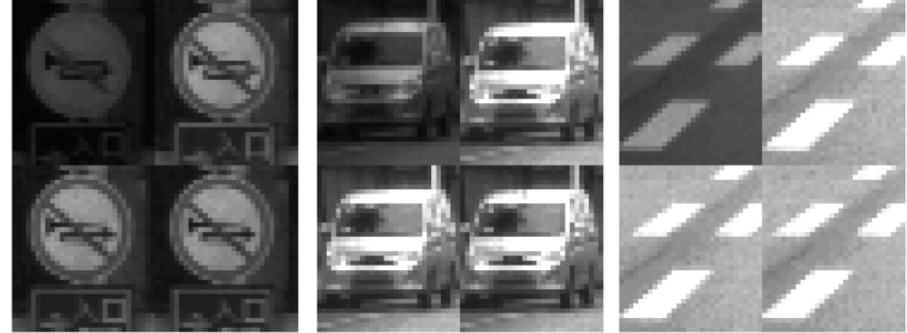
Figure 5. Three sample parts of source RCCC image decomposed into four images with all com- ponents R, C1, C2, C3 separated.